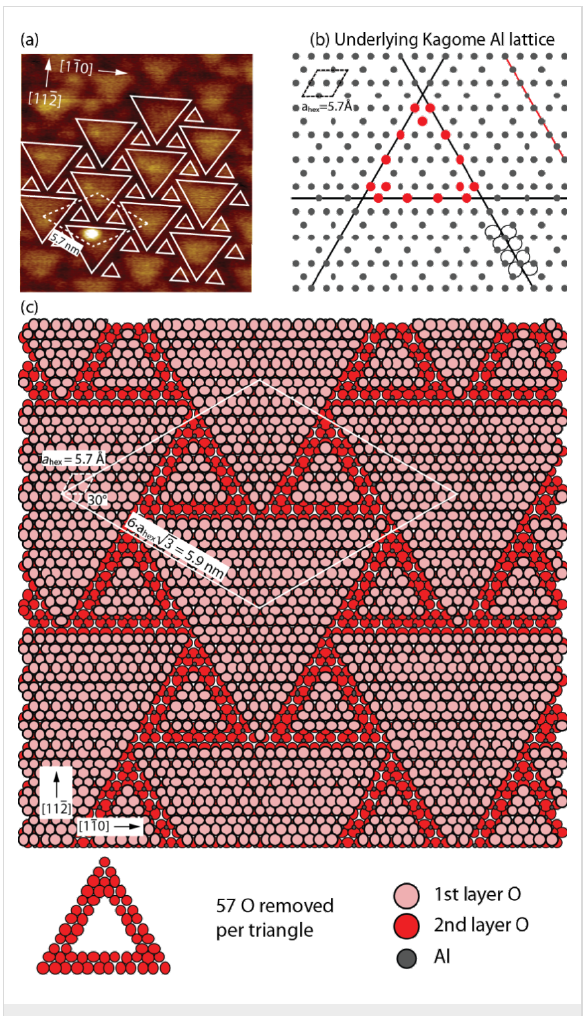
Figure 3: (a) Experimental NC-AFM image with the surface super- structure model superimposed. (b) Illustration of the subjacent aluminium lattice exposing a Kagomé pattern, which facilitates the for- mation of triangular patches. The O atoms are indicated along the black lines in order to illustrate the coordination along the lines. (Al: small grey, O: large, red). (c) Ball model illustrating the (6 √ 3×6 √ 3)R30° superstructure observed on the MgAl 2 O 4 (111) surface. The super- structure is created be the removal of oxygen atoms in triangular